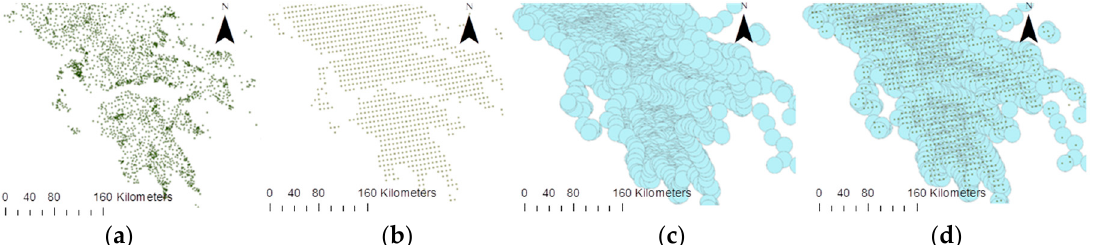
Figure 2. From left to right: Example showing ( a ) calculated centroids of functional elementary catchments (FEC) polygons, ( b ) calculated centroids of PCR-GLOBWB model raster cells, ( c ) buffer zones created based upon the FEC centroids and ( d ) the PCR-GLOBWB centroid cells that fall within the created buffer zones.